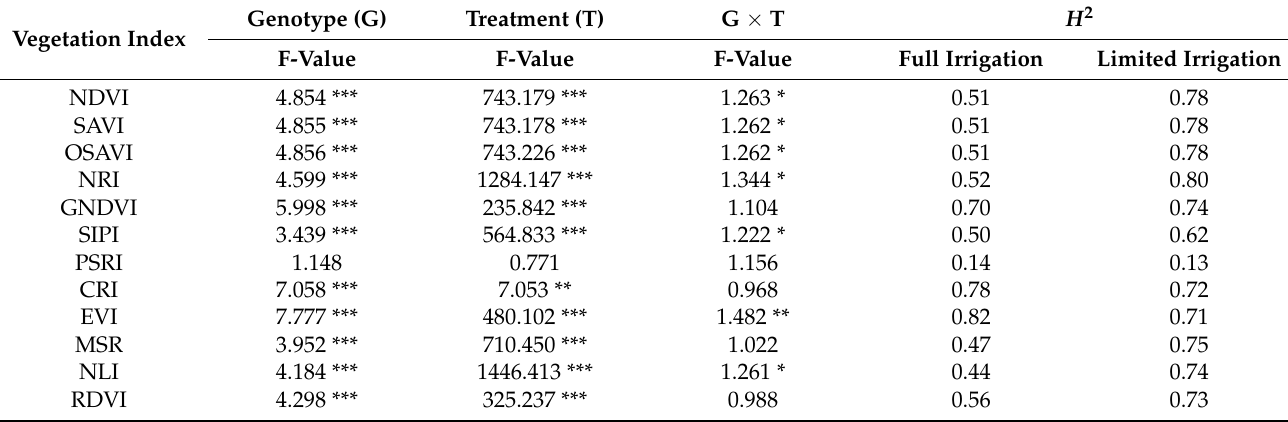
Table A2. Significance test and heritability of the vegetation indexes extracted in the heading stage. Vegetation